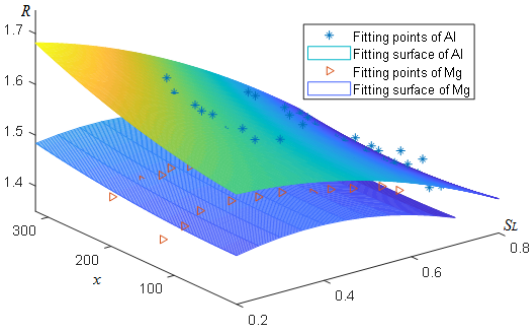
Figure 11. S L - x - R R_value calibration surface of light metals Al and Mg.